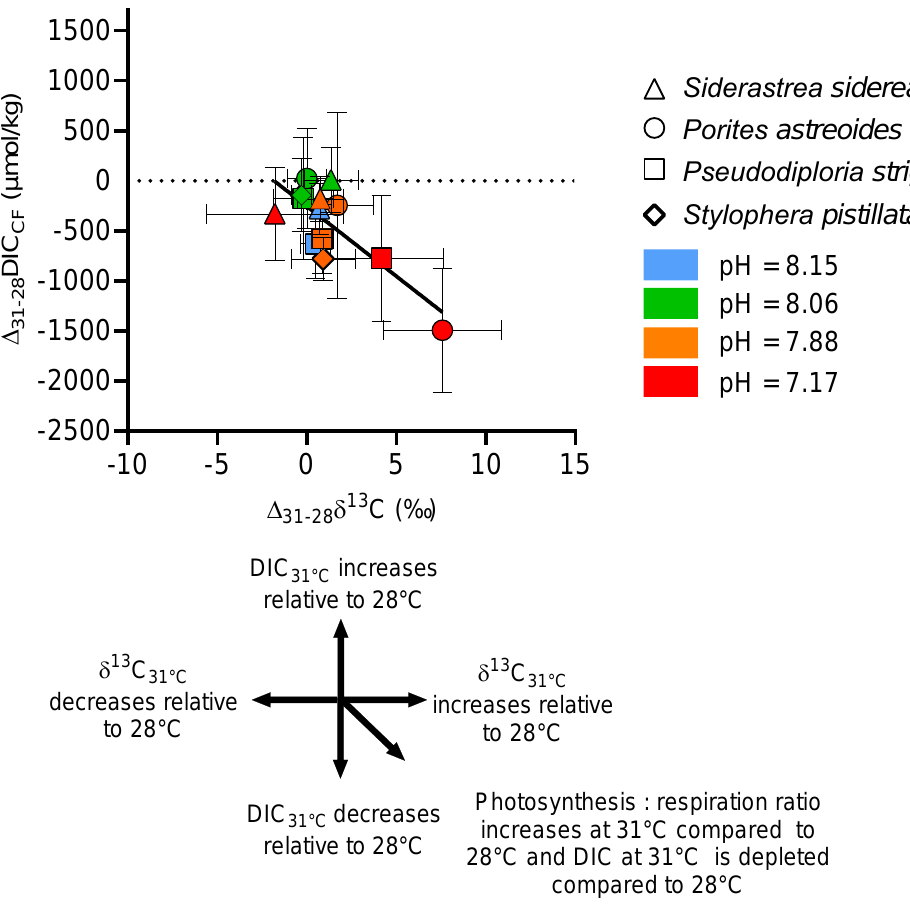
Figure 10. Combined influence of temperature and p CO 2 on the δ 13 C and [DIC] of the coral calcifying fluid. Data are expressed as ∆ δ 13 C ( δ 13 C 31 ◦ C − ∆ δ 13 C 28 ◦ C ) and ∆ [DIC] ([DIC] 31 ◦ C − [DIC] 28 ◦ C ) for each p CO 2